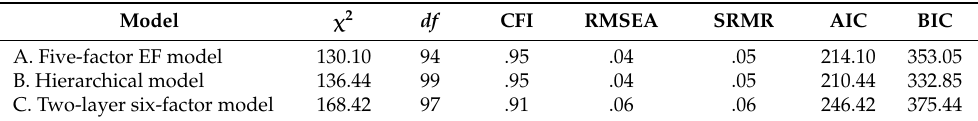
Table 3. Fit statistics of executive functioning (EF) models.